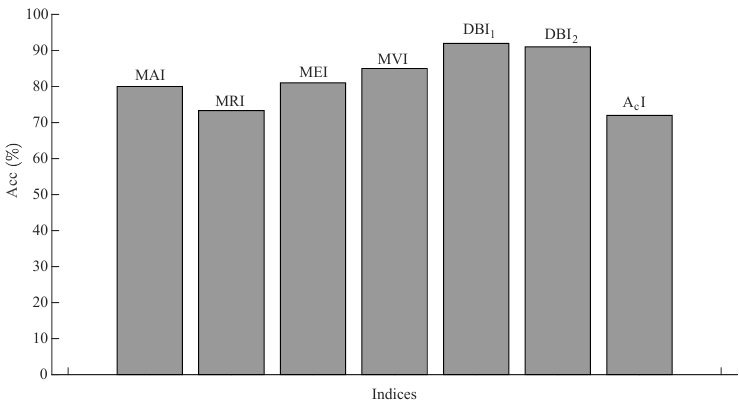
Figure 17. Accuracies of the indices used in the proposed method.